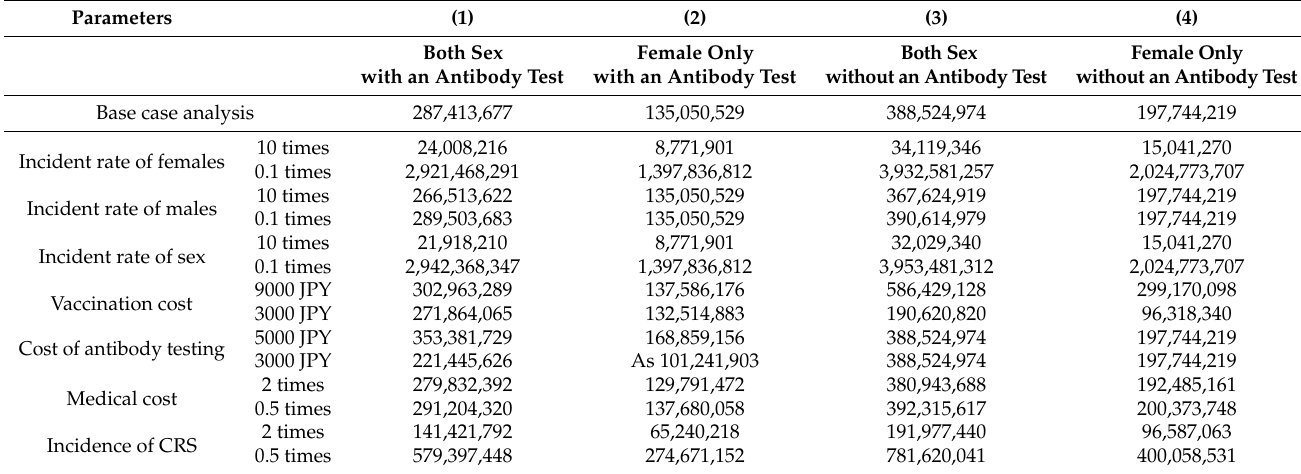
Table 3. Sensitivity analysis of the cost effectiveness of the four